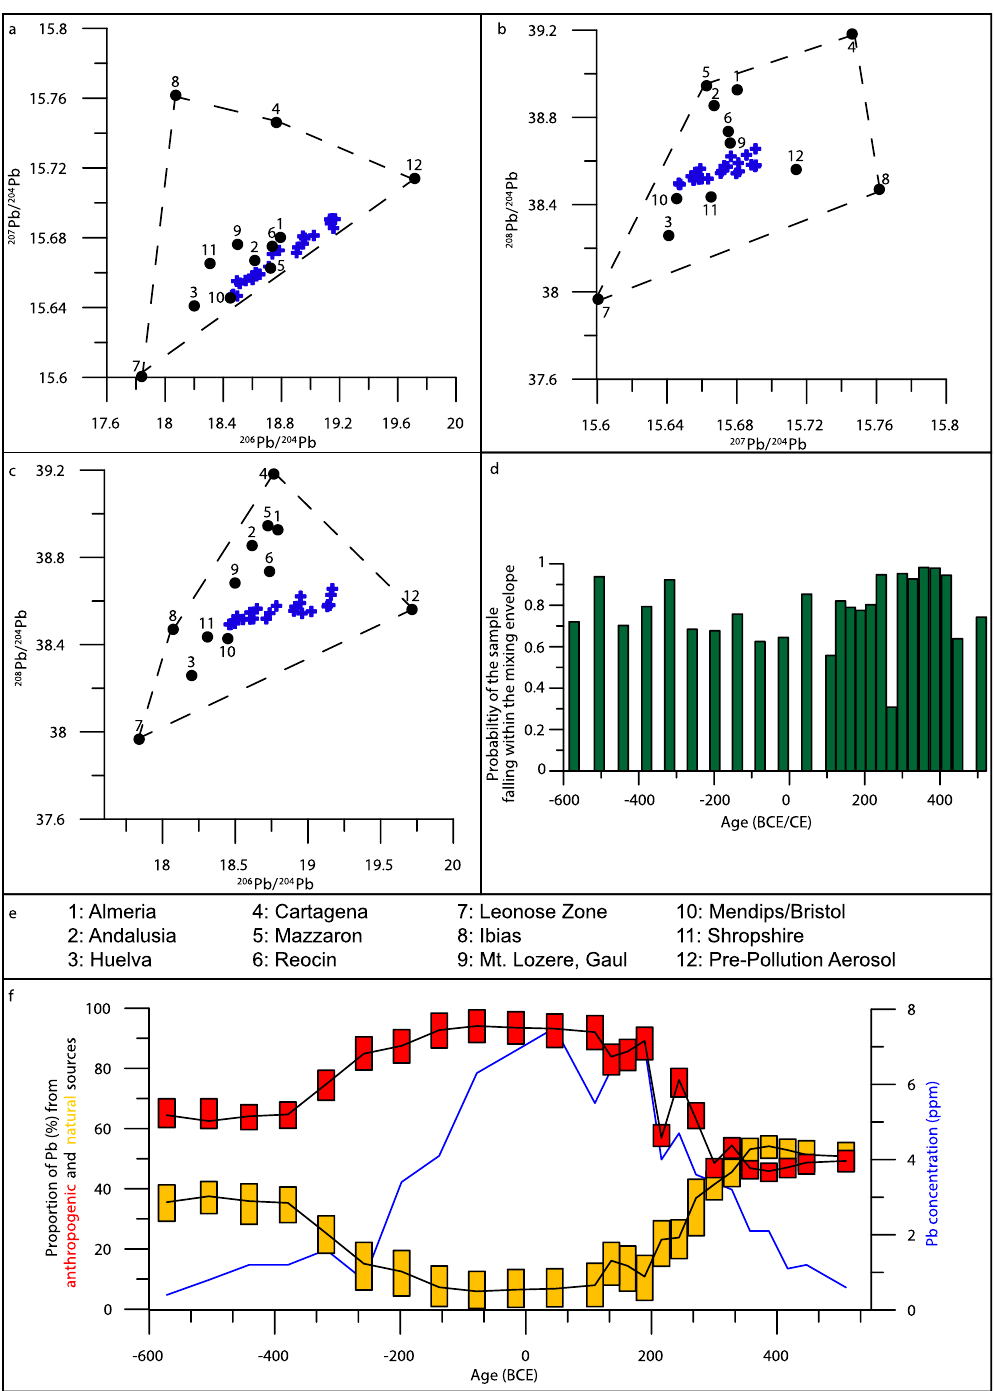
Figure 4. Convex hulls ( a – c ) from Penido Vello bog during the Roman period. As in a, black circles denote sources, with each labelled in panel 5e. Panel 5d displays the output from mixing envelope modelling, indicating all samples fall within the mixing space, and so there are no red crosses on panels 4a–c. 4 f is the model output from Penido Vello between 600 BCE and 550 CE. Red rectangles correspond to a posteriori grouping of all anthropogenic sources, while yellow rectangles are the modelled contribution for Pb from natural sources. Rectangles indicate upper and lower bounds as in Fig. 3, with black lines indicating the mean. Also shown (blue line) are the raw reported Pb concentrations for the core throughout this period 52